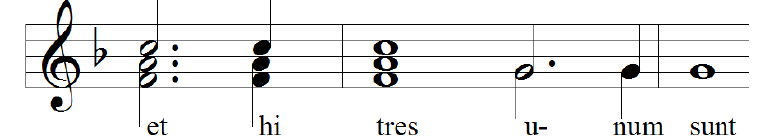
Figure 1. Claudio Monteverdi, Vespro della Beata Vergine , 1610, “Duo